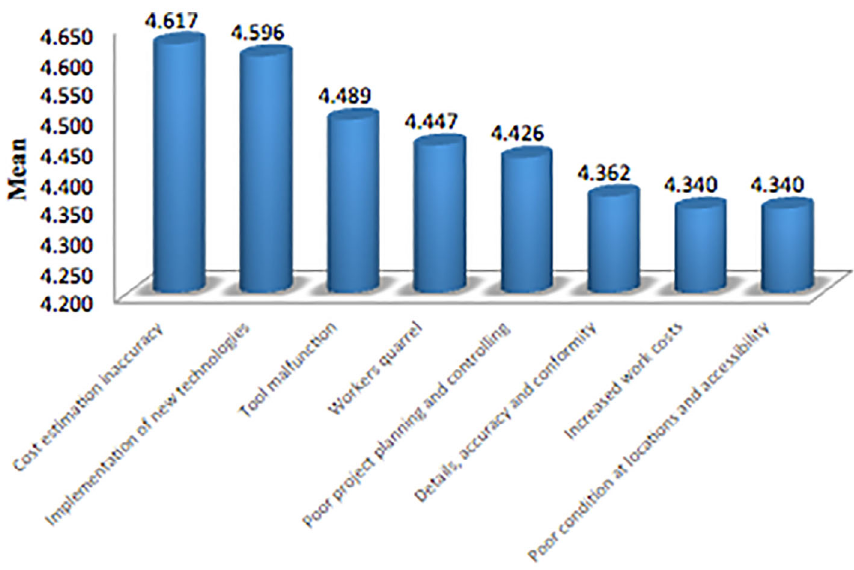
Figure 1. The mean values for the top eight factors are based on the results of the